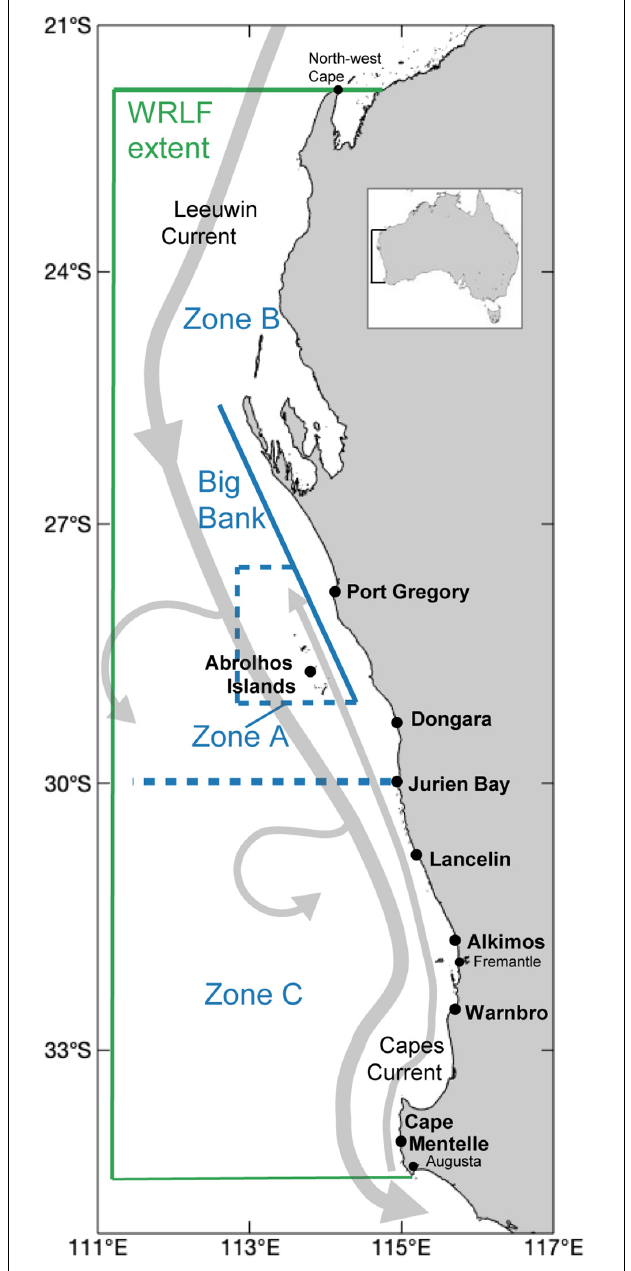
FIGURE 1 | The extent of the Western Rock Lobster Fishery (WRLF) (green). The zones and key areas of the WRLF are in blue (de Lestang et al., 2012). These spatially define management controls. Current puerulus survey sites are indicated by the locations in bold. Schematic includes the referenced currents systems in gray. Eddies generated by the Leeuwin Current flow down the continental shelf are seen and the approximate location of the Cape Current is